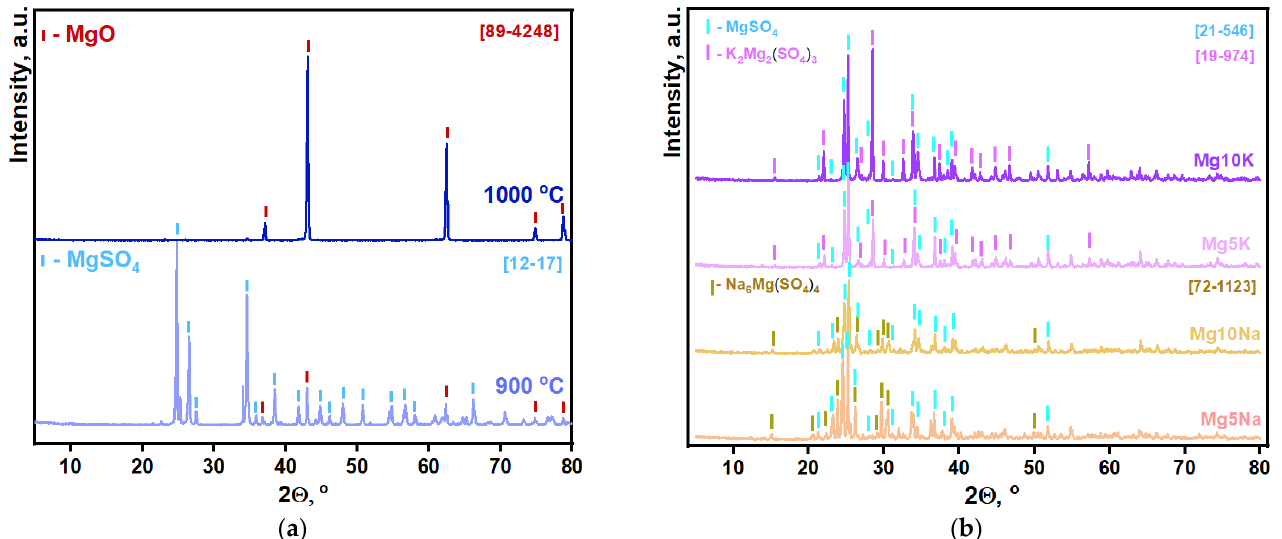
Figure 2. XRD data of the samples: ( a ) MgSO 4 after firing at 900 and 1000 °C; ( b ) Mg5K and Mg10K after firing at 850 °C, and Mg5Na and Mg10K after firing at 800 °C.